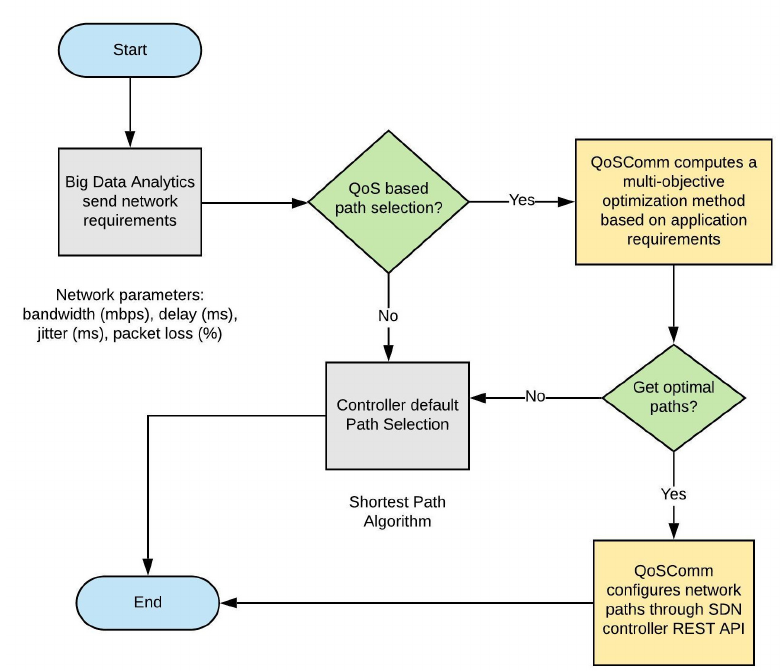
Figure 2. QoSComm general flow forwarding selection